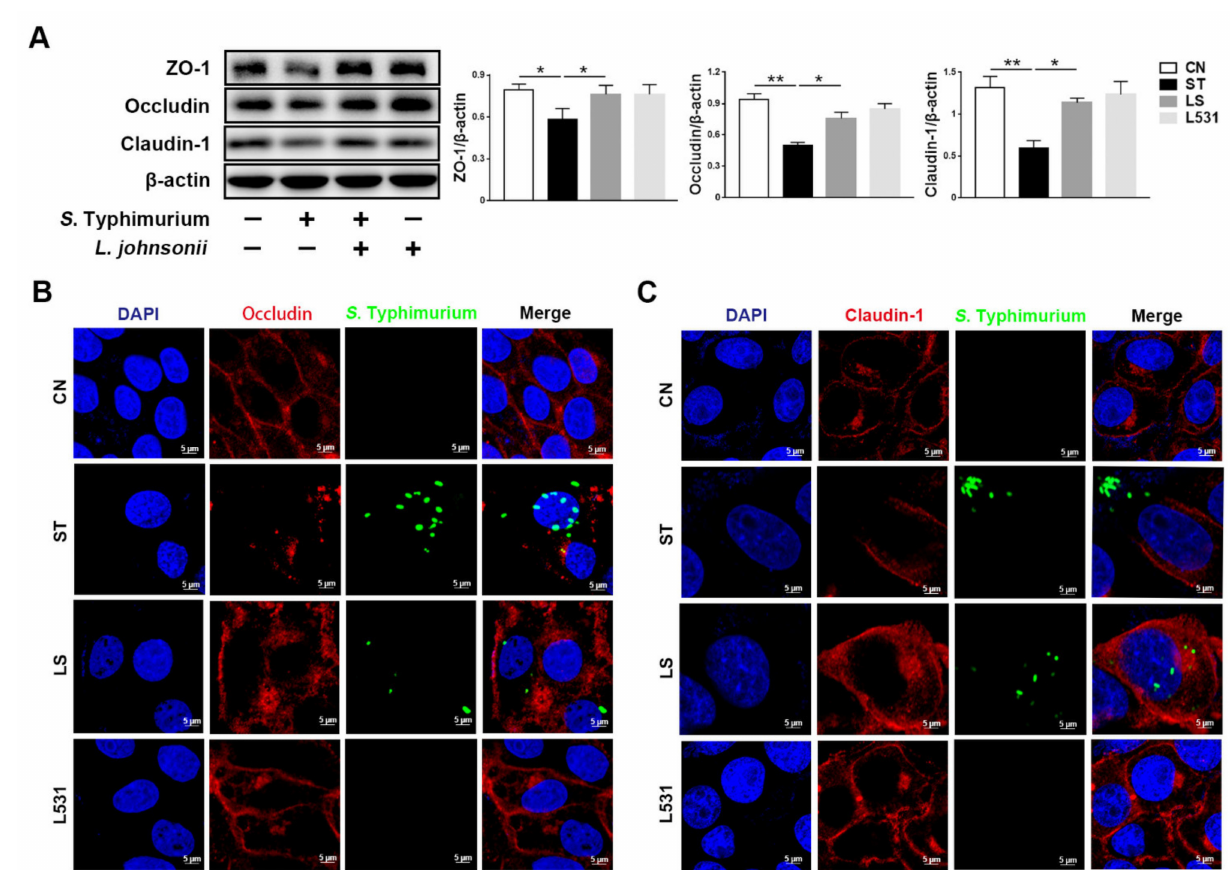
Figure 2. L. johnsonii L531 attenuates S. Typhimurium-induced damage of tight junctions in IPEC-J2 cells. ( A ) West- ern blotting of ZO-1, Occludin, Claudin-1. ( B ) Representative immunofluorescence images of S. Typhimurium (green), Occludin (red), DAPI (blue) stains the nucleus. Scale bar, 5 µ m. ( C ) Representative immune-fluorescence images of S. Typhimurium (green), Claudin-1 (red), DAPI (blue) stains the nucleus. Scale bar, 5 µ m. CN (Control), ST ( S. Typhimurium), LS ( L. johnsonii L531 + S. Typhimurium), L531 ( L. johnsonii L531). The panels show proteins quantification using ImageJ software (version 1.50). The values are shown as the mean ± SEM; n = 3. * p < 0.05, ** p <